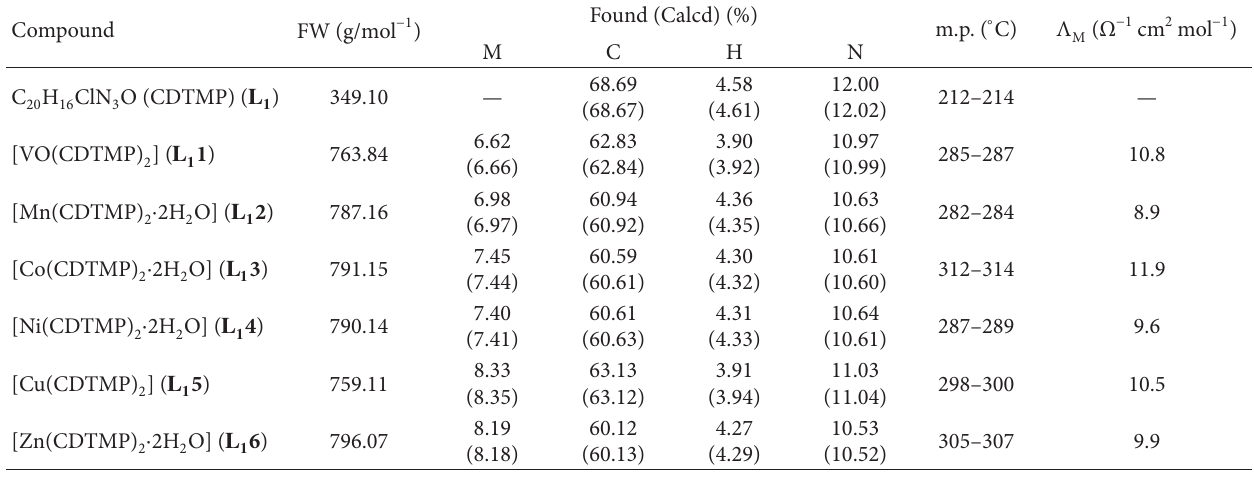
T 1: Physical characterization, analytical and molar conductance data of the ligand (CDTMP,